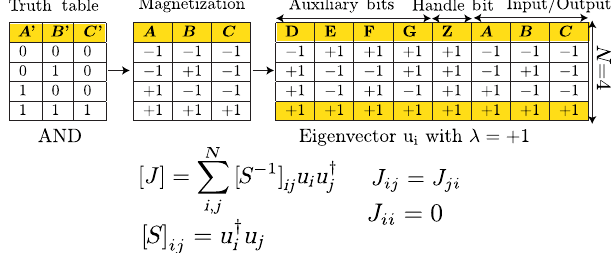
FIG. 6. Truth table to J matrix. A given truth table is first transformed from binary to bipolar variables by using the transformation m ¼ 2 t − 1 , where m and t represent the mag- netization and binary values of the truth table. Additional bits are introduced to each line of the truth table to ensure that the resultant S matrix is invertible. The indices i , j correspond to the number of lines in the truth table. u i , u j are column vectors. As an example, we show auxiliary bits that result in an S matrix equal to the identity matrix, since the eigenvectors are orthogonal. The J matrix is then obtained by Eq. (12a), which ensures that the truth table corresponds to the low-energy states of the Boltzmann machines according to Eq. (4). A handle bit of þ 1 is introduced to each line of the truth table, which can be biased to ensure that the complementary truth table does not appear along with the desired one. This bit also allows a truth table to be electrically reconfigured into its